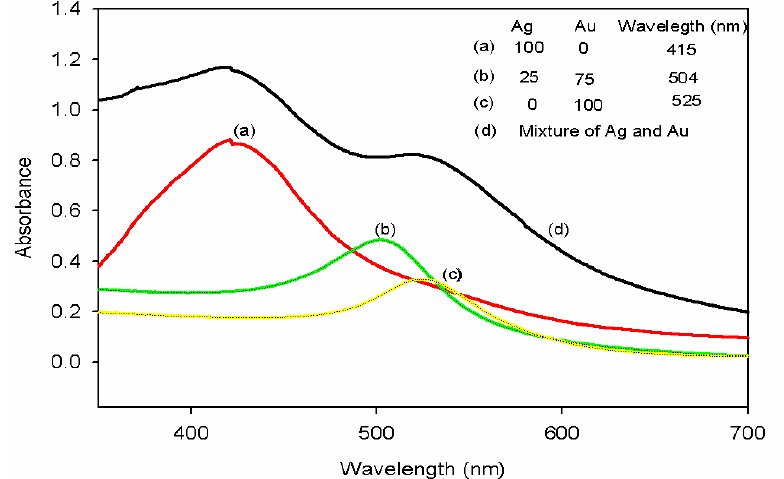
Figure 1. UV-vis absorption spectra of Ag (curve a ), Au (curve c ), Ag-Au alloy (curve b ) nanoparticles and a mixture of pure Ag and Au nanoparticles (curve d ).